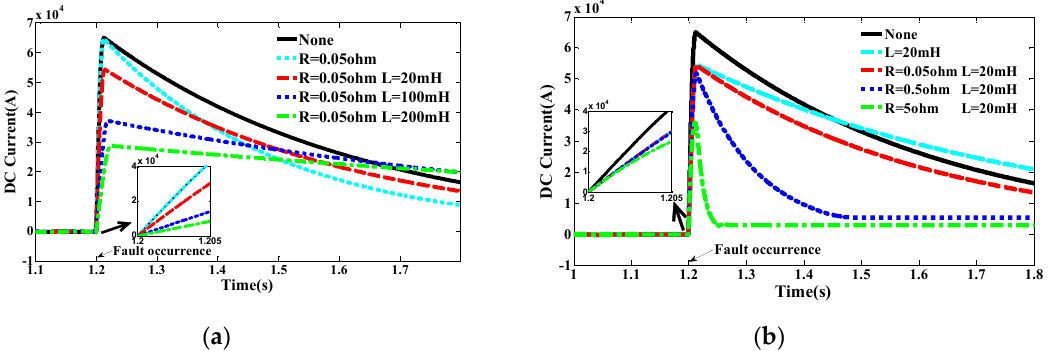
Figure 11. DC fault current characteristics ( a ) with variable limiting inductance; ( b ) with variable energy dissipation resistance. Table 2. Condition classification for the fault current limiting circuit scheme.